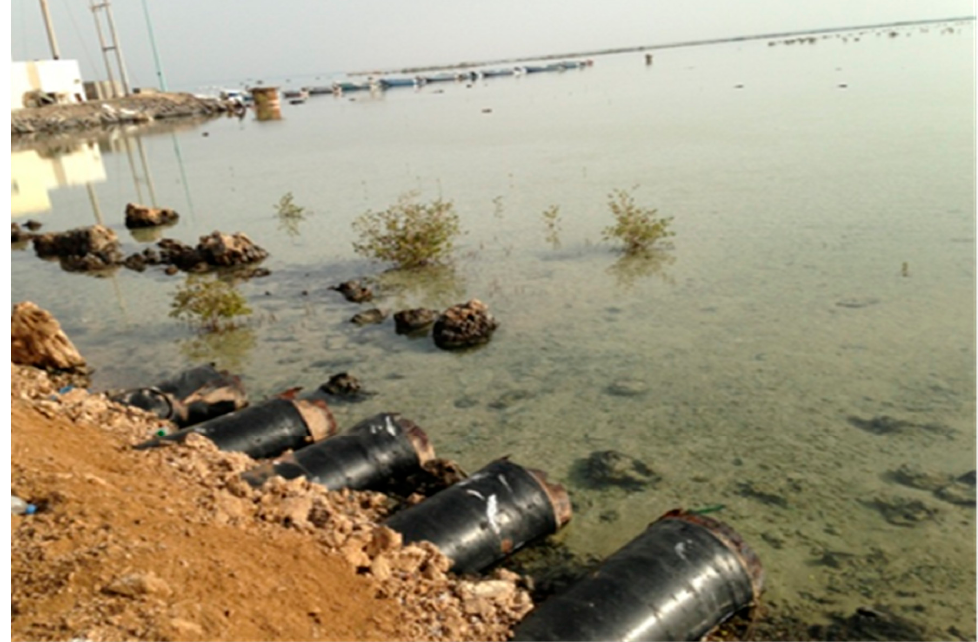
Figure 12. Pipes laid down under the sand passage to allow water circulation.